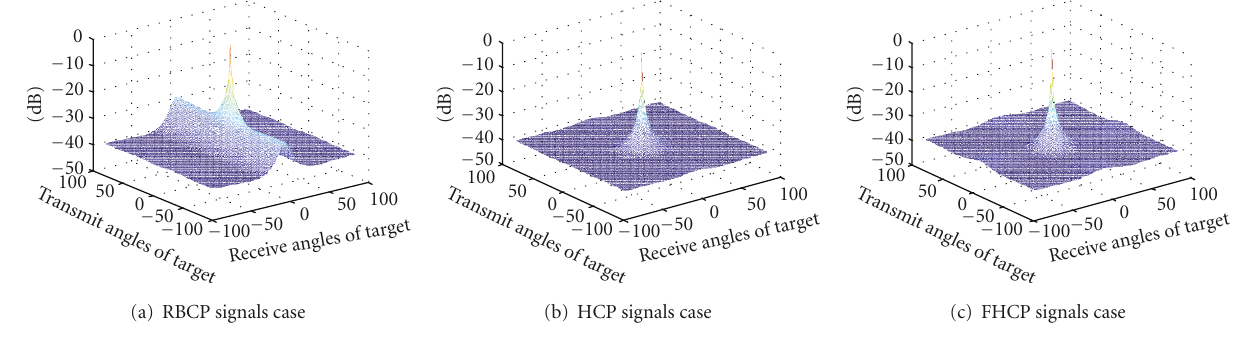
Figure 7: Performance of one target locates at θ t = 0 ◦ , θ r = 0 ◦ , σ 2